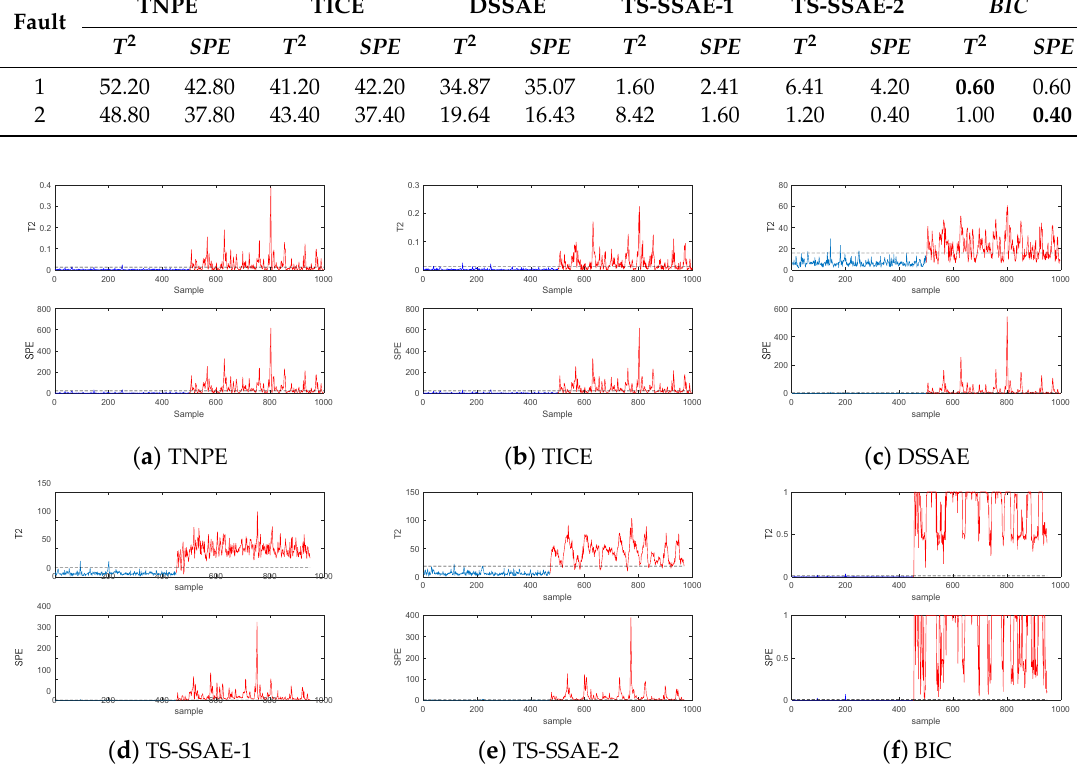
Figure 5. Monitoring results of fault 1 in the case study.